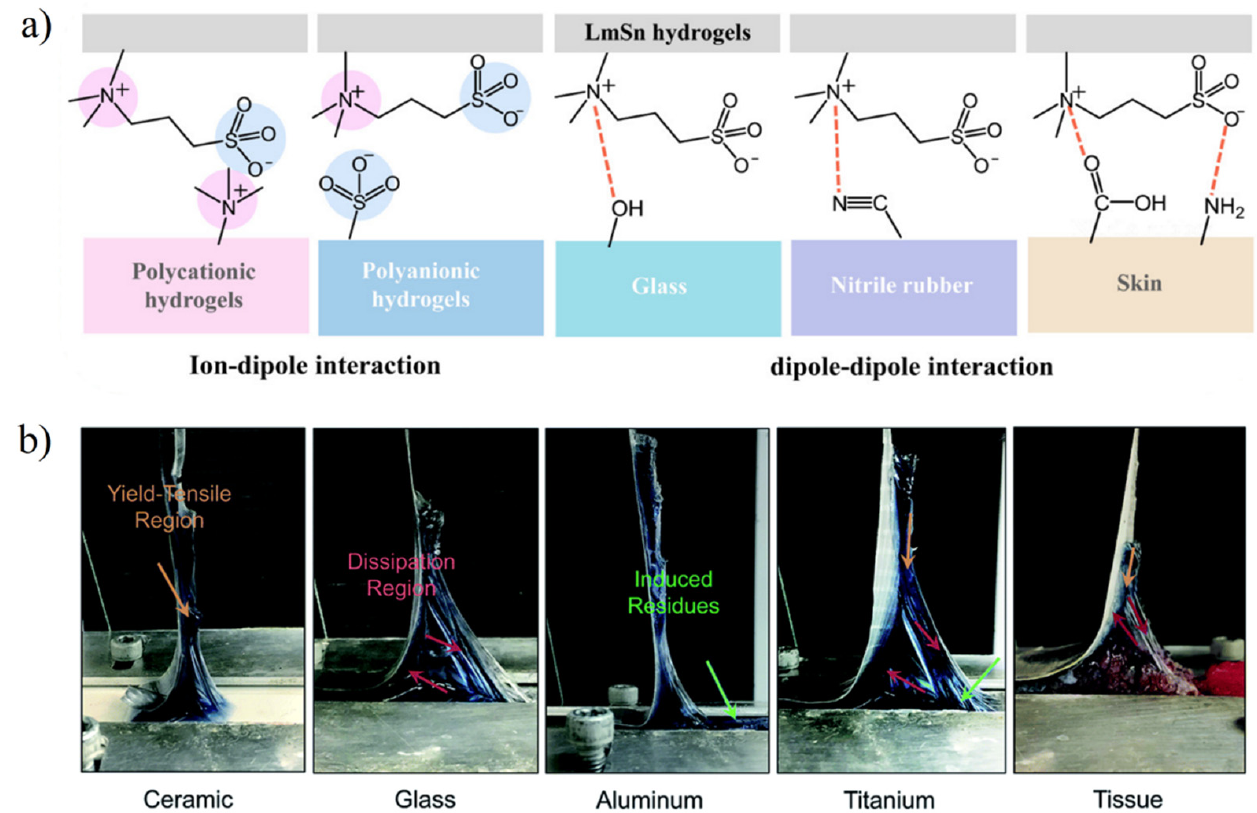
Figure 7. Adhesion between zwitterionic hydrogels and various substrates. ( a ) Adhesive mechanism of Laponite XLG composite SBMA hydrogel (LmSn) via ion–dipole interaction and dipole–dipole interaction between hydrogel and surface. Reproduced with permission from [74]. Copyright 2019, American Chemical Society. ( b ) Images of peeling off a test of adhesive zwitterionic hydrogel from nonporous surfaces. Synergistic of hydrogen bond interaction and dipolar interaction provided strong adhesive force. Reproduced with permission from [59]. Copyright 2020 The Royal Society of